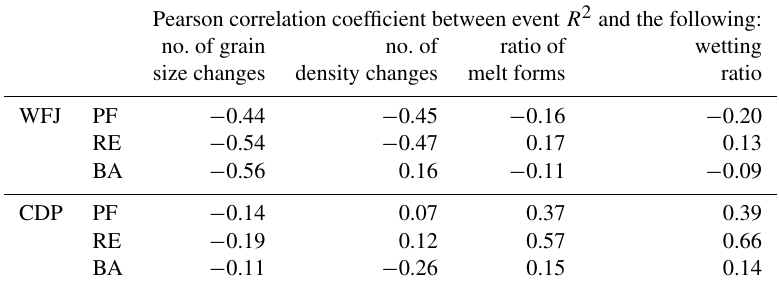
Table 4. Pearson correlation coefficients between event- R 2 and stratigraphic features at WFJ and CDP. Stratigraphic features are marked